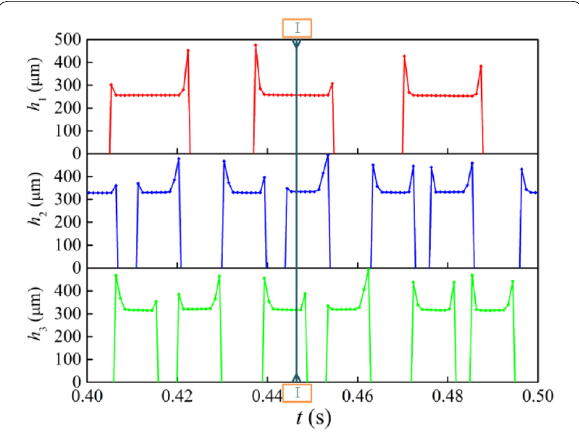
Figure 7 Oscillogram of data collected